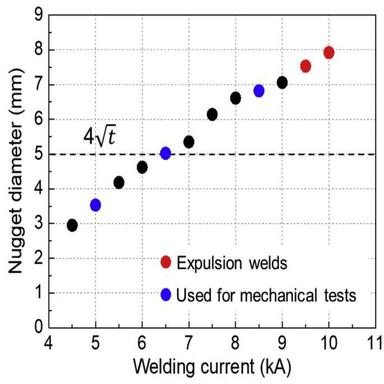
Nugget diameter as a function of welding current.